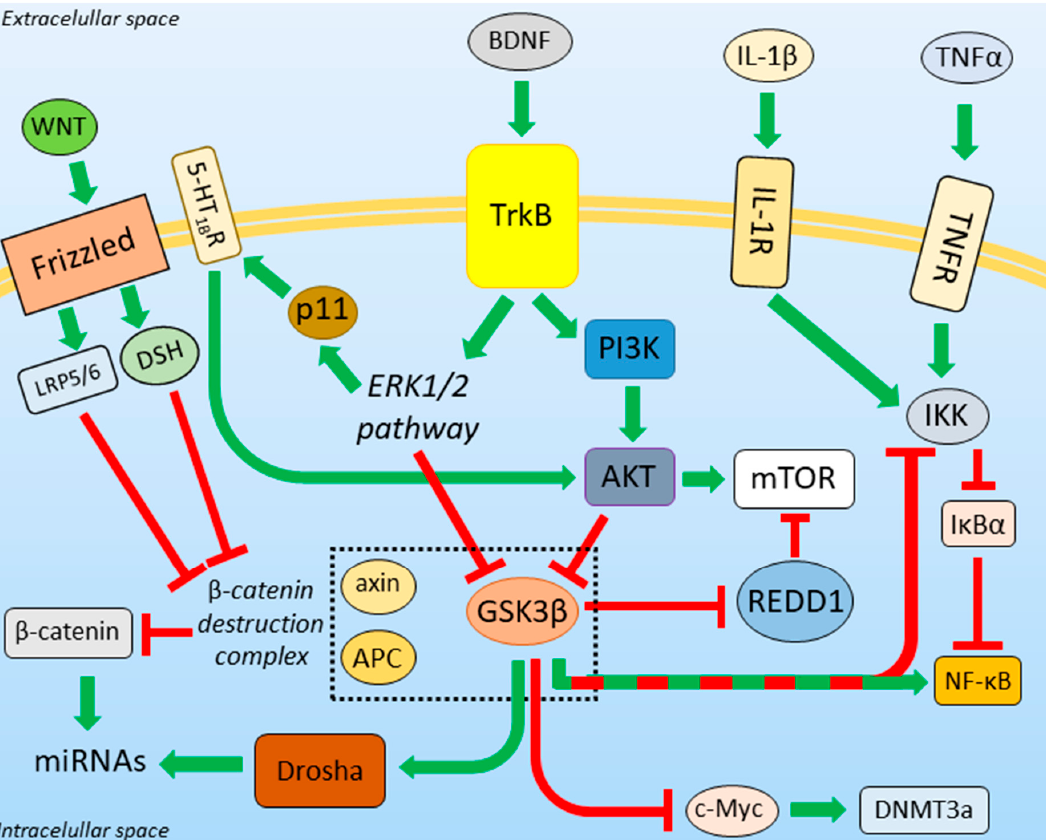
Figure 2. GSK3 β is a part of neurotrophic and pro-inflammatory factors signaling pathways. Green arrows represent activation, red arrows represent inhibition. Green-red arrow denotes a dual, dependent on the physiological state of a cell, action of GSK3 β . Abbreviations: WNT: Wingless-related integration site, LRP5/6: low-density lipoprotein receptor-related protein 5 and 6, DSH: Disheveled, 5-HT 1B R—serotonin 1B receptor, ERK: extracellular signal-regulated kinase, APC: adenomatous polyposis coli, BDNF: brain-derived neurotrophic factor, TrkB: tropomyosin receptor kinase B, PI3K: phosphoinositide 3-kinase, AKT: protein kinase B, IL-1 β : interleukin 1 β , IL-1R: interleukin 1 β receptor, TNF α : tumor necrosis factor α , TNFR: tumor necrosis factor α receptor, IKK: I κ B kinase, I κ B α : nuclear factor of light polypeptide gene enhancer in B-cells inhibitor α , NF- κ B: Nuclear factor κ -light-chain-enhancer of activated B cells, mTOR: mammalian target of rapamycin, REDD1: regulated in development and DNA damage response-1, DNMT3a: DNA methyltransferase 3a, GSK3 β : glycogen synthase kinase 3 β .